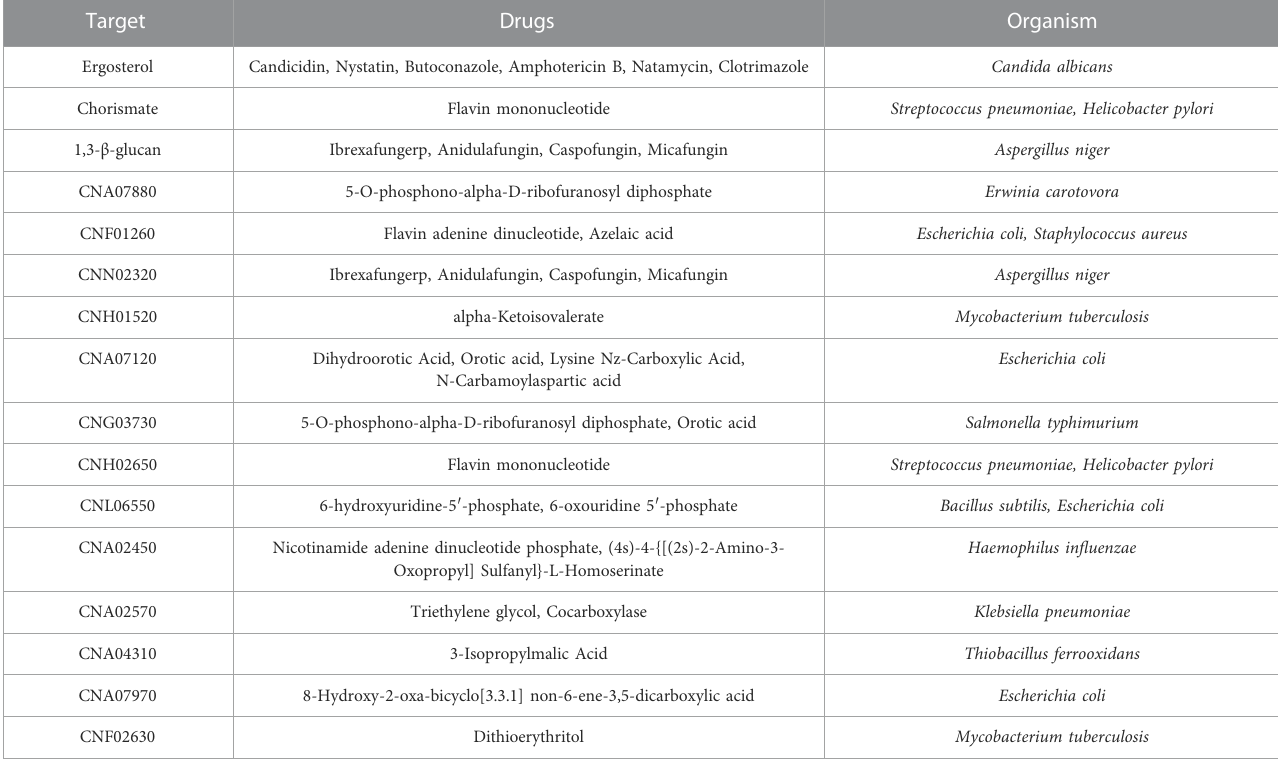
TABLE 5 Drugbank